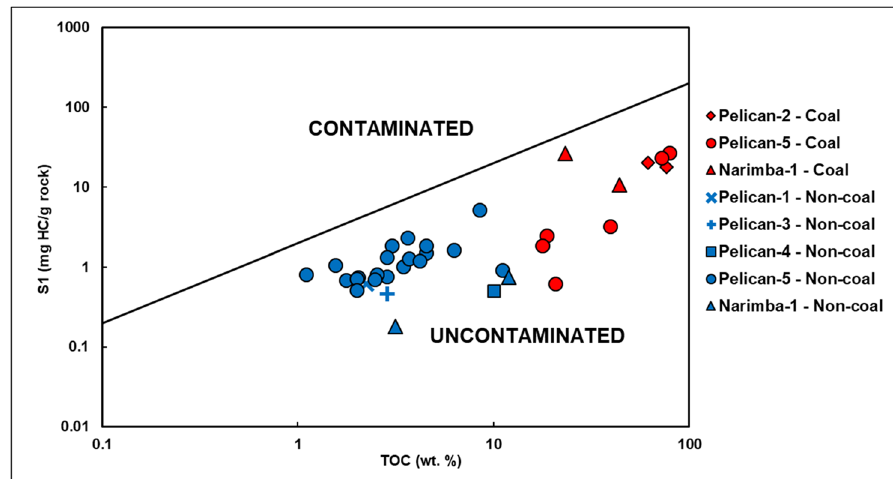
Fig. 4 A cross-plot of S 1 versus TOC indicating the origin of the hydrocarbon within the Narimba Formation (Fakhri et al.